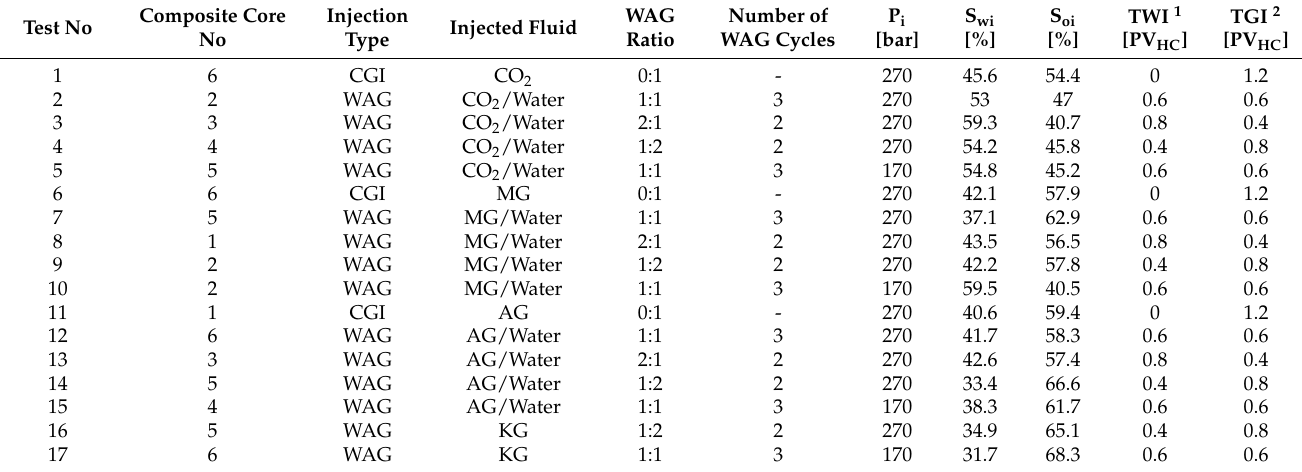
Figure 5. Simplified scheme of the core flooding setup. Table 9. Core flooding experiments